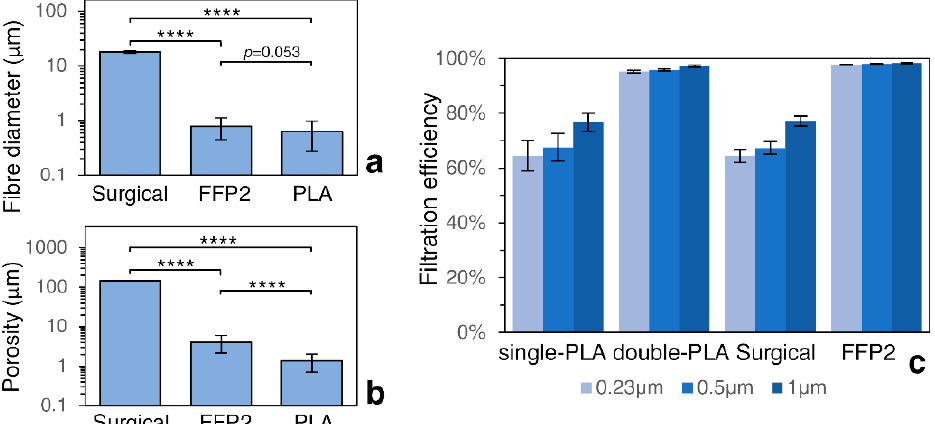
Figure 3. Properties of corresponding filtration media, Knudsen number regimes, flow mechanisms, and filtration efficiency: ( a ) fiber diameter; ( b ) porosity; ( c ) percentage filtration efficiency of particles with diameter 0.23 µ m, 0.5 µ m, and 1 µ m. Significance is expressed by the p -value (**** p < 0.005).